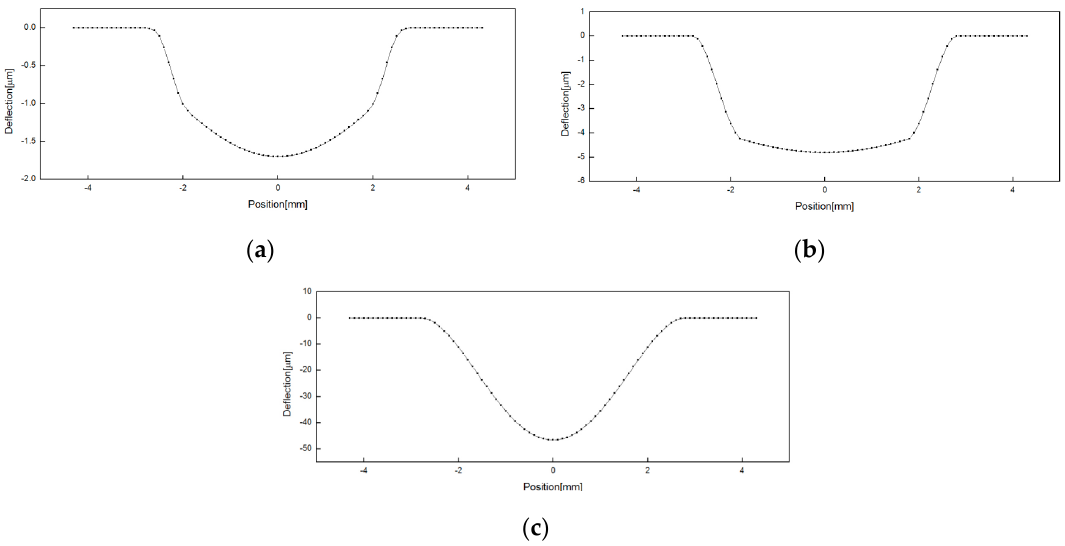
Figure 7. Deflection behavior along the diaphragm axis with t = 0.2 mm, w = 1.05 mm, P = 2.5 MPa: